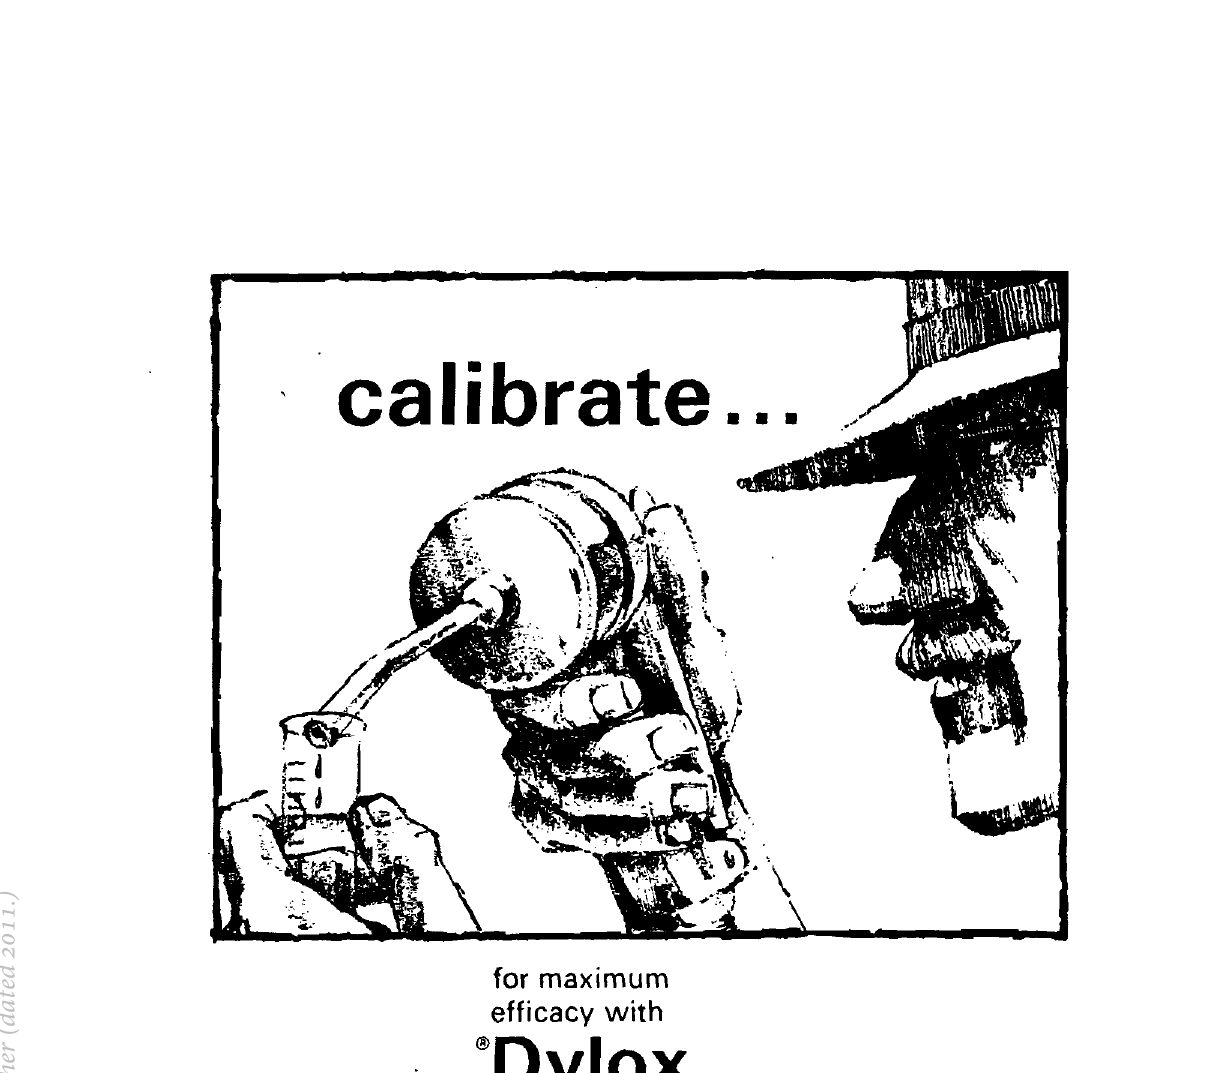
for maximum efficacy with ®Dylox SAFE - FAST ACTING - EFFECTIVE in the control of wire worms, nodular worms, intestinal and stomach bankrupt worms and brown stomach worms in